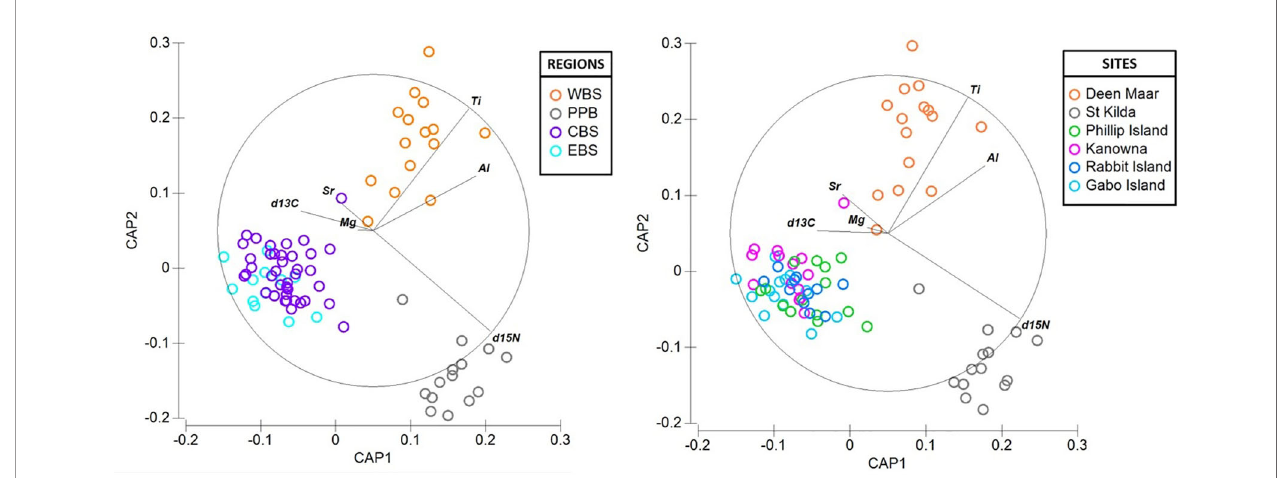
FIGURE 6 | Canonical variate plots of the multi-elemental and isotope chemistry of feathers of little penguins sampled across four regions; (A) Western (WBS), Central (CBS) and Eastern Bass Strait (EBS) and Port Phillip Bay (PPB) and (B) sites; Deen Maar Island, St. Kilda, Phillip Island, Kanowna Island, Rabbit Island and Gabo Island. Vector diagrams show the direction and weight of individual isotopes and elements to sample